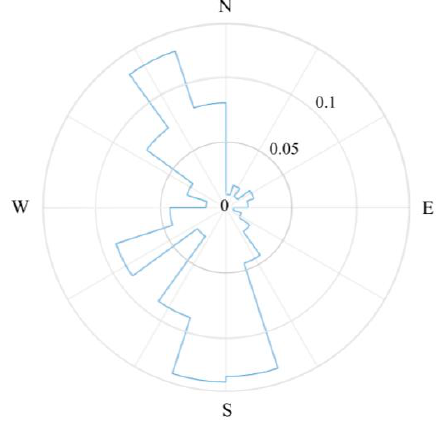
Figure 6. Wind rose diagram. Figure 6. Wind rose